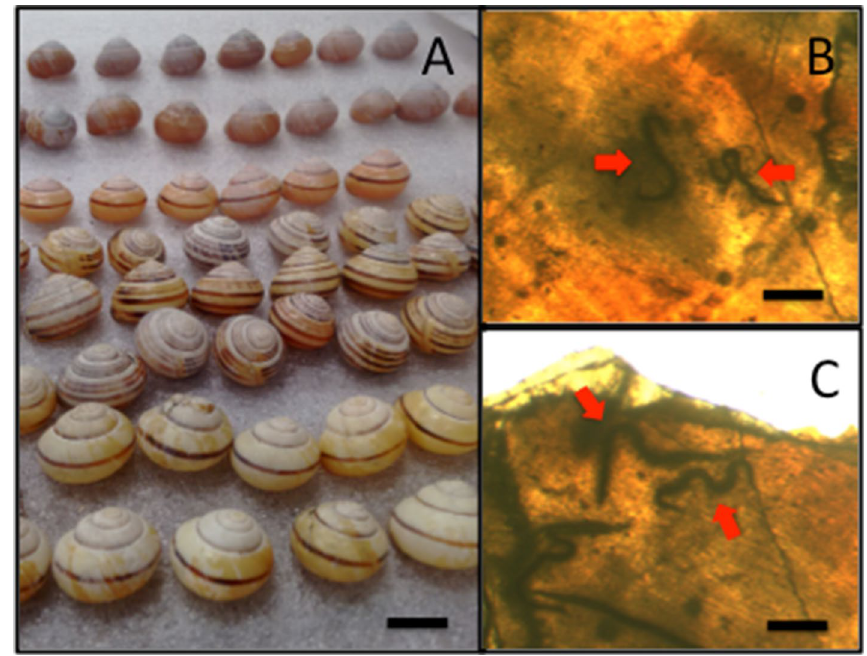
Figure 1. ( A ) Snails, such as C. nemoralis , regularly encase and kill nematodes in the inner whorl of their shell. The nematodes can be seen by using light microscopy and are fused to the inner shell ( B , C ). Bars represent 1 cm in ( A ) and 0.5 mm in ( B , C